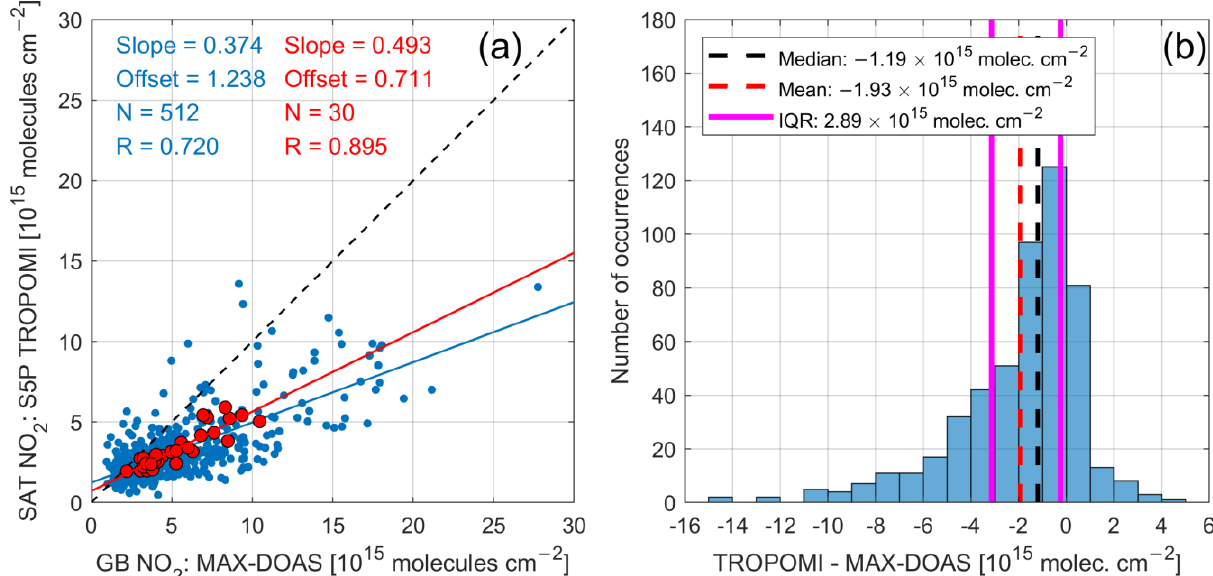
Figure 10. The consolidated comparison of tropospheric NO 2 vertical columns ( a ) between the MAX-DOAS and S5P/TROPOMI for the daily (blue) and monthly mean (red) collocated measurements and the frequency distribution ( b ) of their absolute differences.